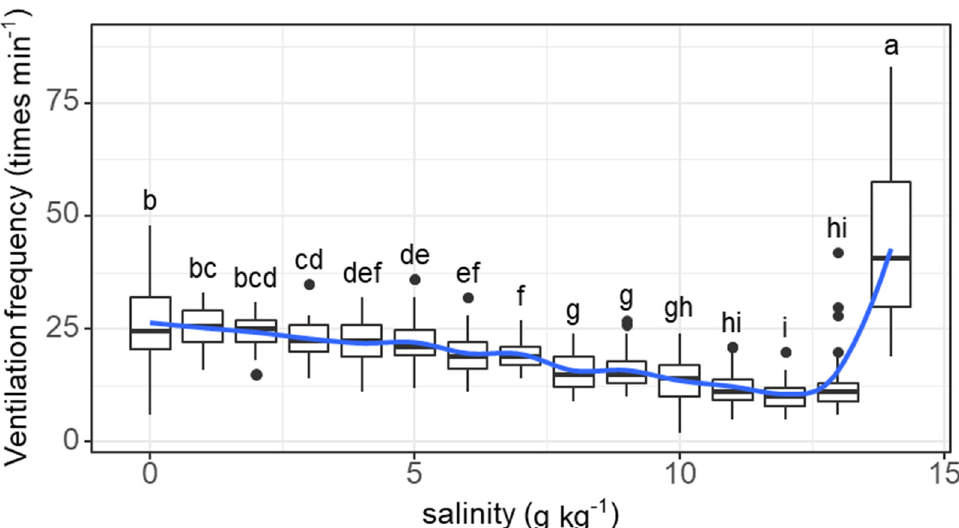
Figure 2. Variations in the ventilation frequency (times min − 1 ) of grass carp with daily increasing salinity (g kg − 1 ). The data are expressed as boxplots, with boxes indicating the upper, middle, and lower quartiles, and vertical lines indicating the upper whisker and lower whisker. The blue curve describes the changing tendency using locally weighted scatterplot smoothing (LOWESS). a–i: Boxes without common superscripts indicate significant differences among salinities ( p < 0.05). Black dot: the outliers.